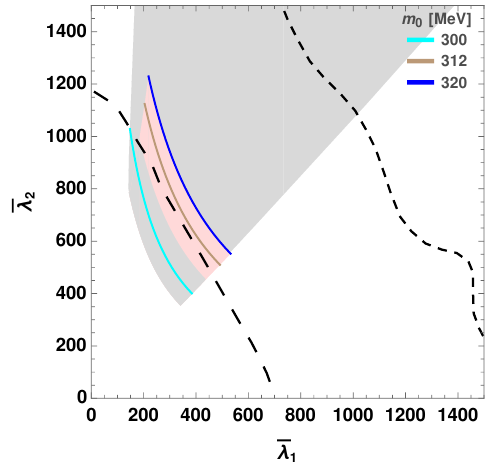
Figure 4 . The tidal deformabilities (cid:22) (cid:21) i obtained for the two stars involved in the binary NS merger observed by LIGO and Virgo [46], corresponding to masses M 1 2 [1 : 36 ; 1 : 60] M (cid:12) and M 2 2 [1 : 17 ; 1 : 36] M (cid:12) (low-spin prior). The curves with the three di(cid:11)erent colors stand for the corresponding small-radius compact star solutions displayed in (cid:12)gure 3. The curves corresponding to the remaining two EoSs of (cid:12)gure 2 fall outside the range of the plot. The gray area represents the set of all viable deformabilities obtained by varying m 0 for the type HS2 stars, whereas the type HS3 stars fall in the pink area.